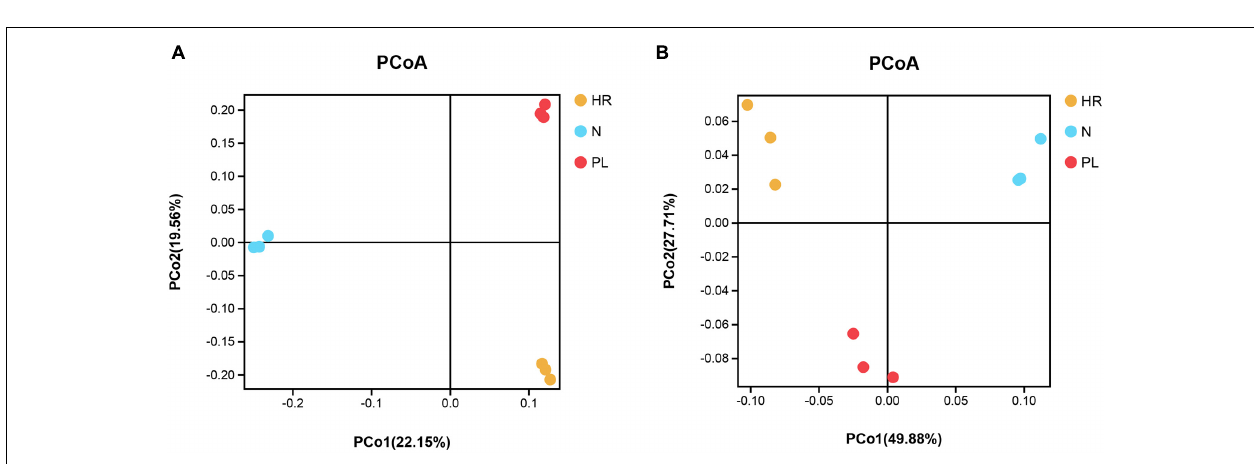
from plants cultivated in the N field. By contrast,